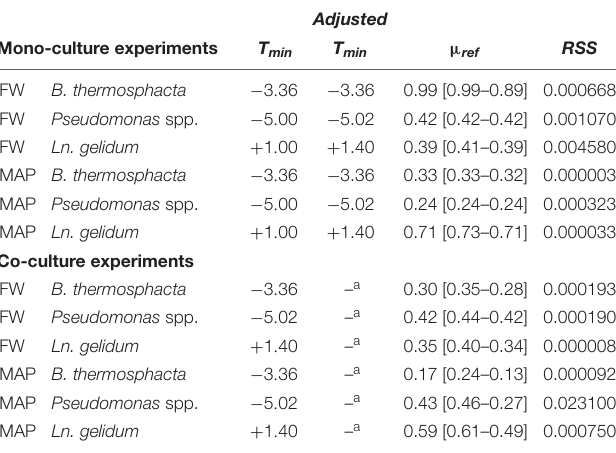
TABLE 5 | Estimation of the secondary parameters obtained by the square root model without interactions.